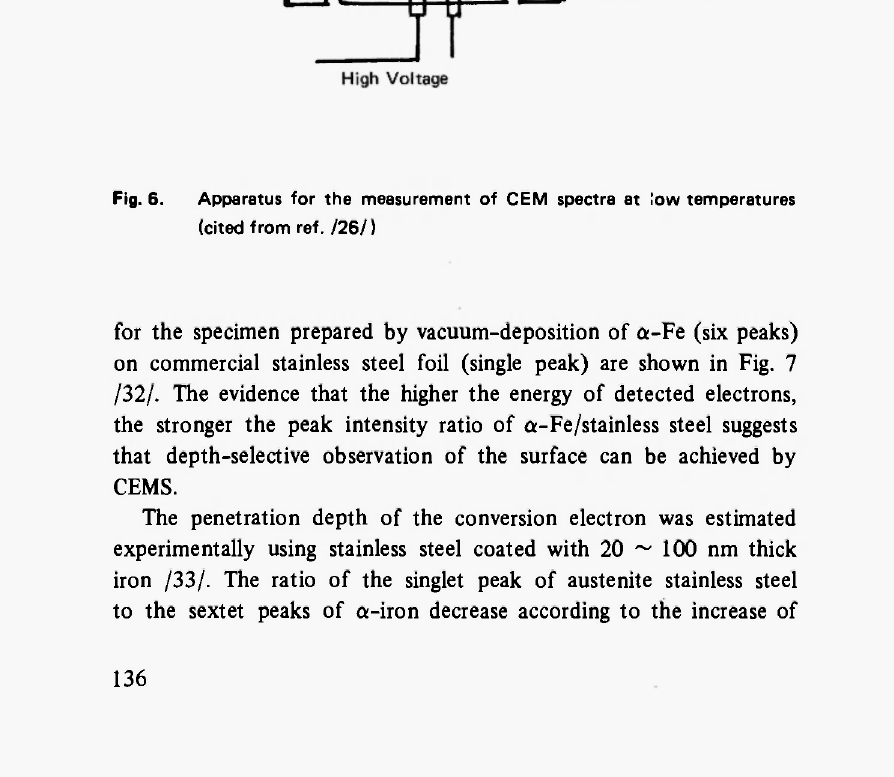
Fig. 6. Apparatus for the measurement of CEM spectra at low temperatures (cited from ref.